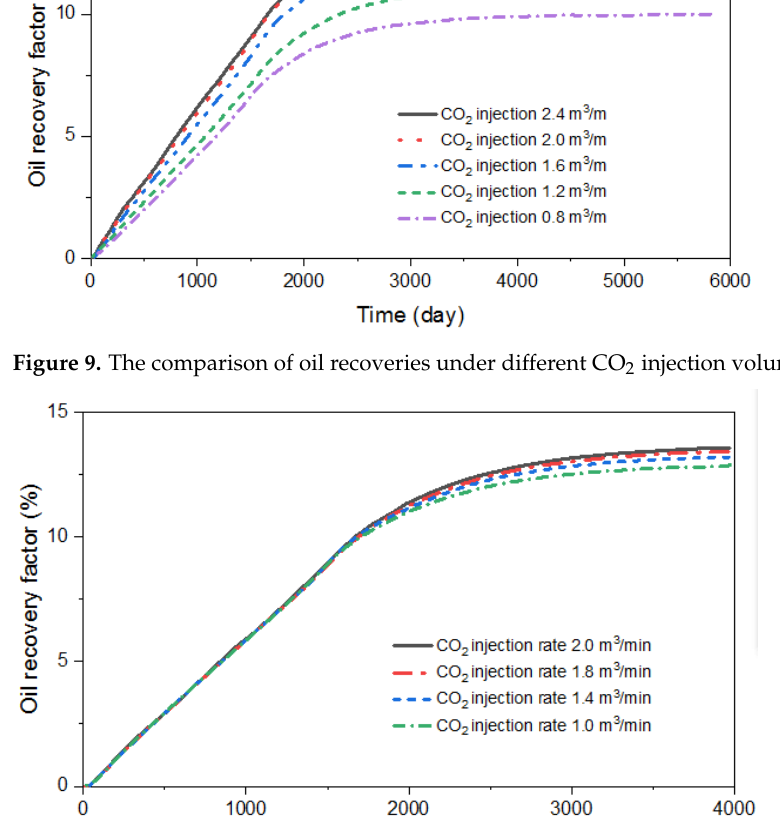
CO 2 injection intensity is 2.0 m 3 /m. The CO 2 injection rate is 1.8 m 3 /min. The soaking time is 30